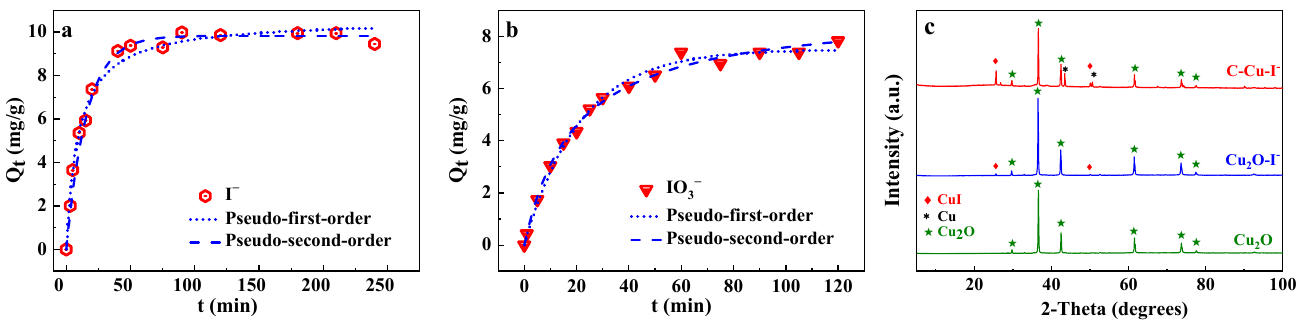
Figure 2. Data on the adsorption of ( a ) iodide ions and ( b ) iodate ions onto C ‐ Cu fitted by kinetic models: C 0 = 10 mg/L, adsorbents 1.0 g/L, 25 °C, pH = 7.0 ± 0.2. ( c ) XRD patterns of Cu 2 O, Cu 2 O ‐ I − , and C ‐ Cu ‐ I − .